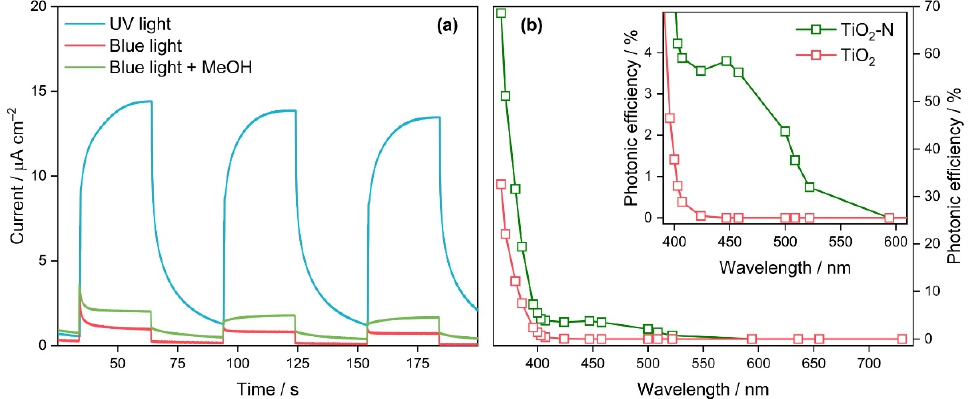
Figure 6. Photocurrent of TiO 2 -N under UV and visible light ( a ); action spectra of TiO 2 -N and TiO 2 synthesized at 350 °C ( b ). The inset in ( b ) shows an enlarged area of action spectra in the range of 380–620 nm.